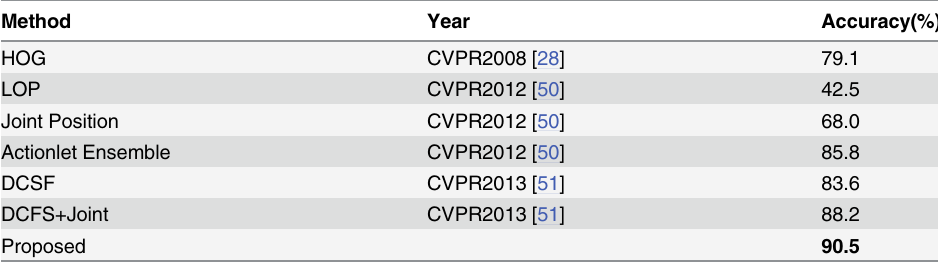
Table 3. Comparison with state of the arts on